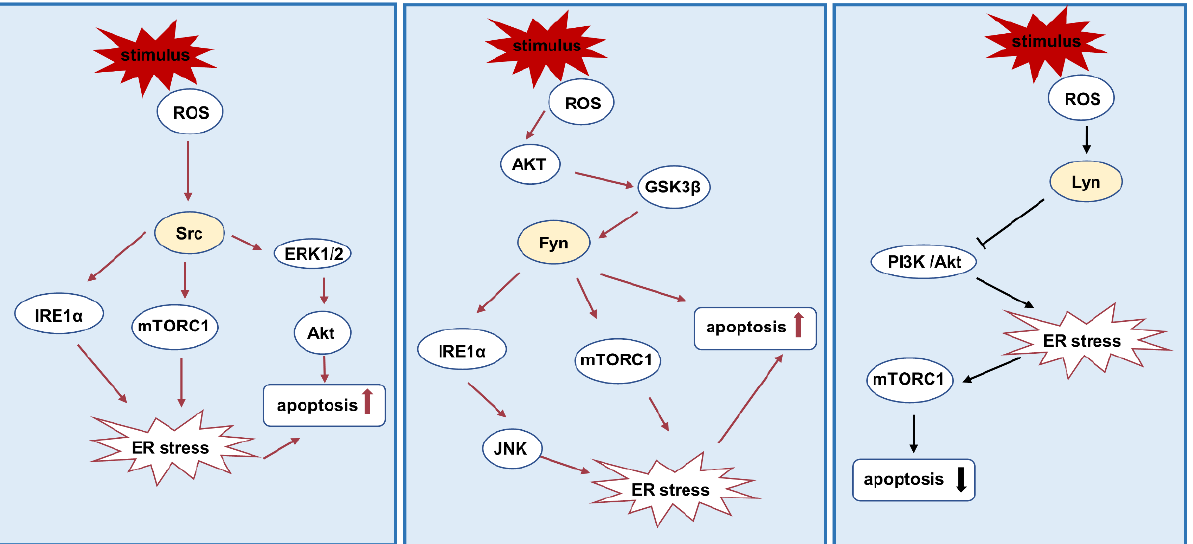
Figure 4. Src family kinases and ER stress. Src and Fyn aggravate oxidative stress and apoptosis by mediating mTORC and ERK1/2 and also interact with IRE1 α to cause oxidative stress. Lyn activation reduces oxidative stress and apoptosis through mTORC. Abbreviations: IRE1 α : inositol-requiring enzyme 1alpha.